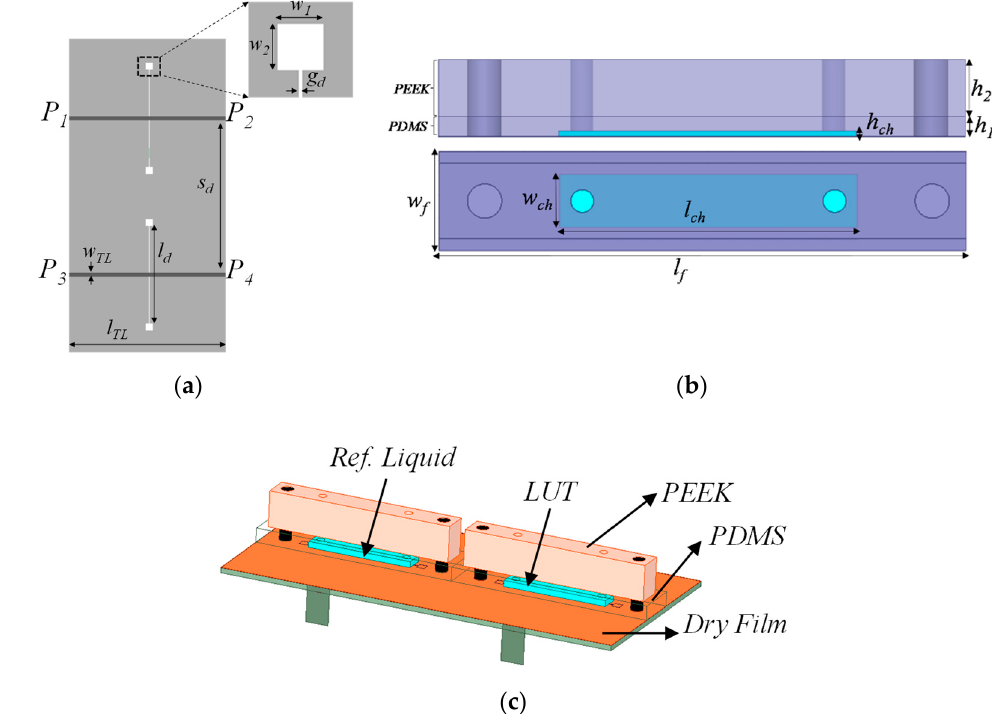
Figure 1. The proposed dumbbell defect ground structure (DGS)-based sensor. ( a ) Topology of the microwave part; ( b ) lateral and top views of the mechanical and fluidic parts; ( c ) complete three-dimensional view. Relevant dimensions are (in mm): w 1 = w 2 = 2, w TL = 1.14, l LT = 50, l d = 28, g d = 0.2, and S d = 44. Channel dimensions are (in mm): h ch = 1.5, l ch = 26, w ch = 4.6, l f = 46, w f = 12.6, h 1 = 3, and h 2 = 9. The considered substrate is Rogers RO3010 with a dielectric constant ε r =